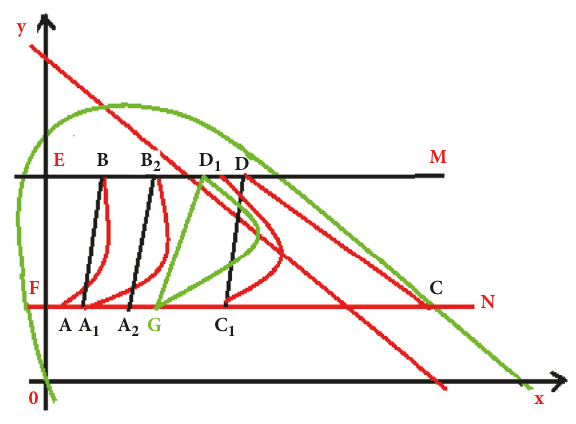
Figure 1: The existenceof order-1 periodic solution of system (6) for 𝐻 < 𝑦 ∗ .